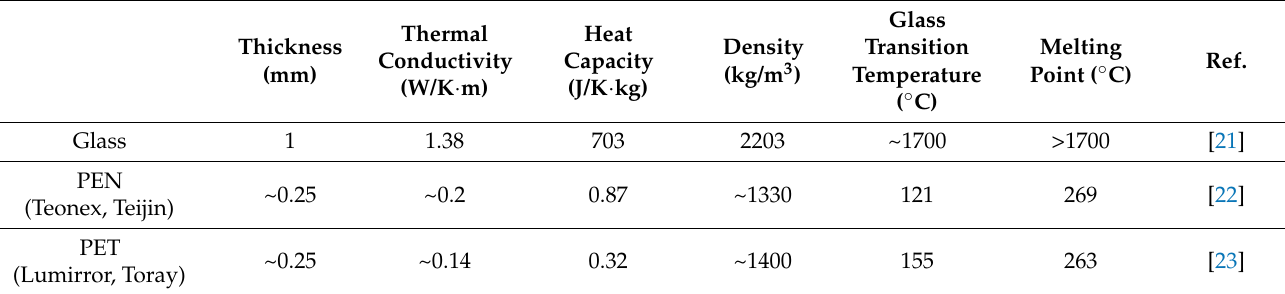
Figure 1. Procedure for the laser direct writing of cobalt/cobalt oxide composite materials using femtosecond laser reductive sintering of cobalt oxide nanoparticles. Table 1. Physical parameters of the